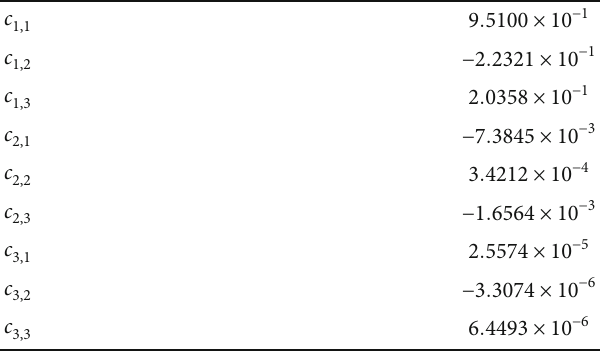
Figure 1: De fi nition of the SFAP parameters. The peak-peak amplitude is measured from the maximum positive and negative peaks (A to B). The time di ff erence two between zero-crossings (C and D) is the negative peak duration. Table 1: The values of the coe ffi cients c in Equation (3).